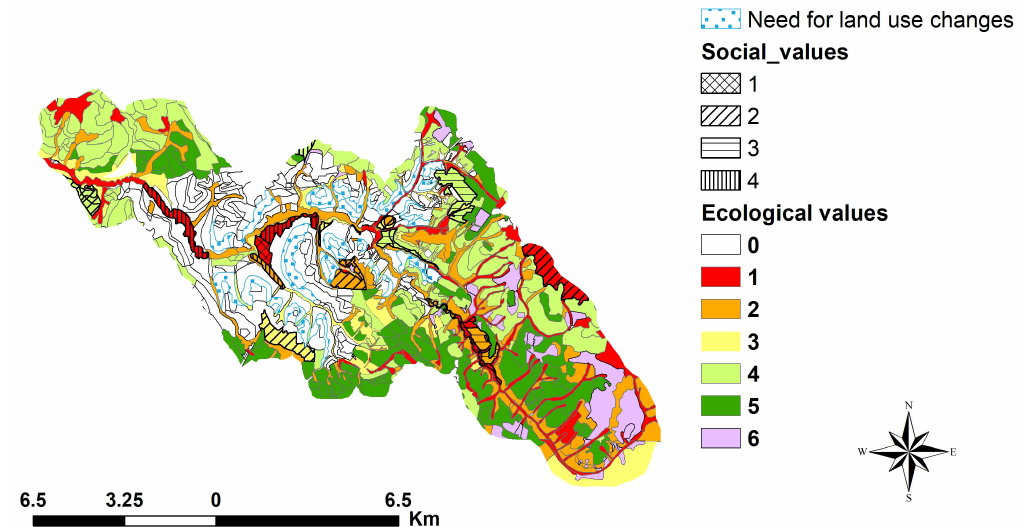
Figure 5. Needs for changes in land use, ecological and social values in the Zayachya river basin. Ecological values: 0 ‐ no ecological values; 1 ‐ high internal value (key habitats) and significant control over remote areas (biocorridor, runoff regulation, protection of rivers from siltation); 2 ‐ high internal value (key habitats, rare units); 3 ‐ buffer effects between the anthropogenically disturbed units and water bodies; 4 ‐ disturbed forest units at intermediate stages of recovery successions with a high value for feeding animals; 5 ‐ typical zonal type units with biotope functions and water ‐ regulating capacity; 6 ‐ temporal loss of most ecological values after cutting. Social values: 1 ‐ cemetery; 2 ‐ popular areas for gathering berries and mushrooms, 3 ‐ hunting sites; 4 ‐ recreation sites.